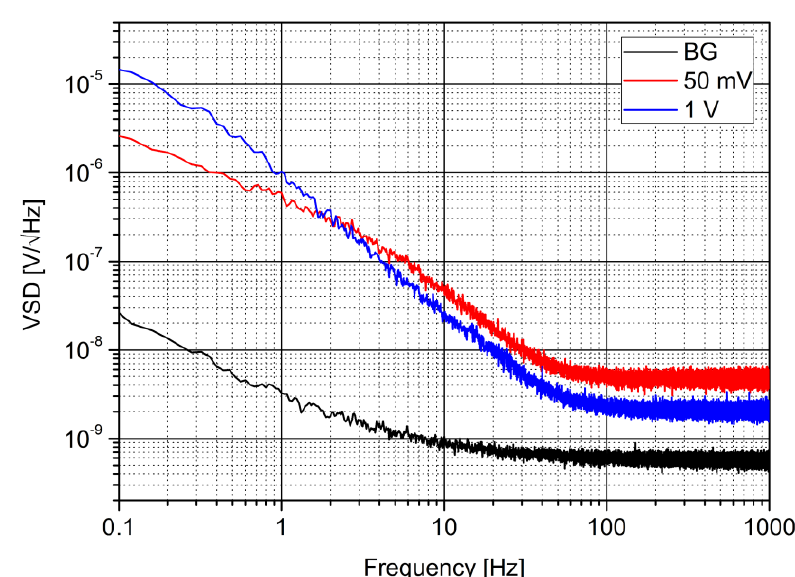
Figure 8. VSD characteristics of the voltage source in Figure 7 for different output voltages (red and blue lines) and noise background (black line).